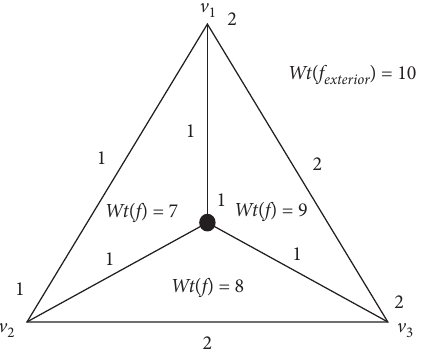
Figure 4: 2-labeling of a wheel graph W